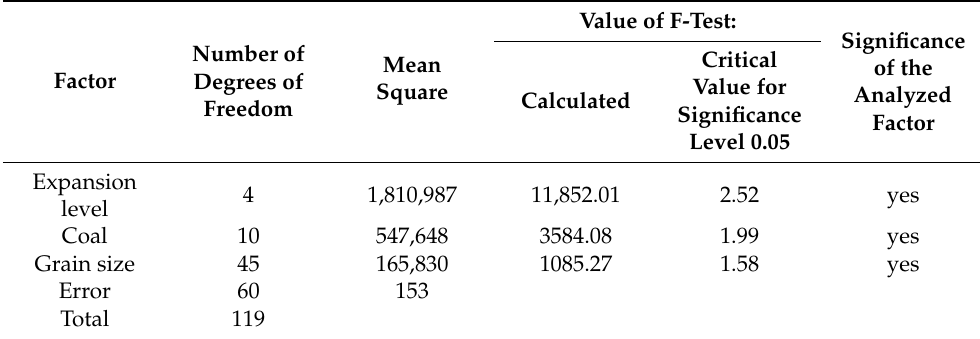
Table 1. Final results of statistical verification of the correlation between the analyzed factors and the coking pressure generated by coal within the temperature range of its plasticity. Number of Mean Factor Degrees of Square Freedom